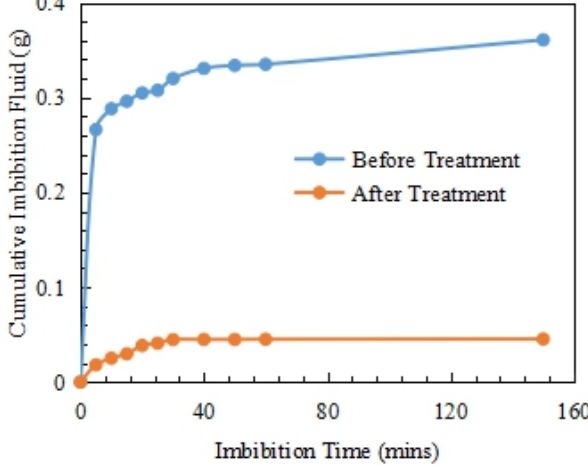
Figure 17. Air-brine cumulative spontaneous fluid curve [27].